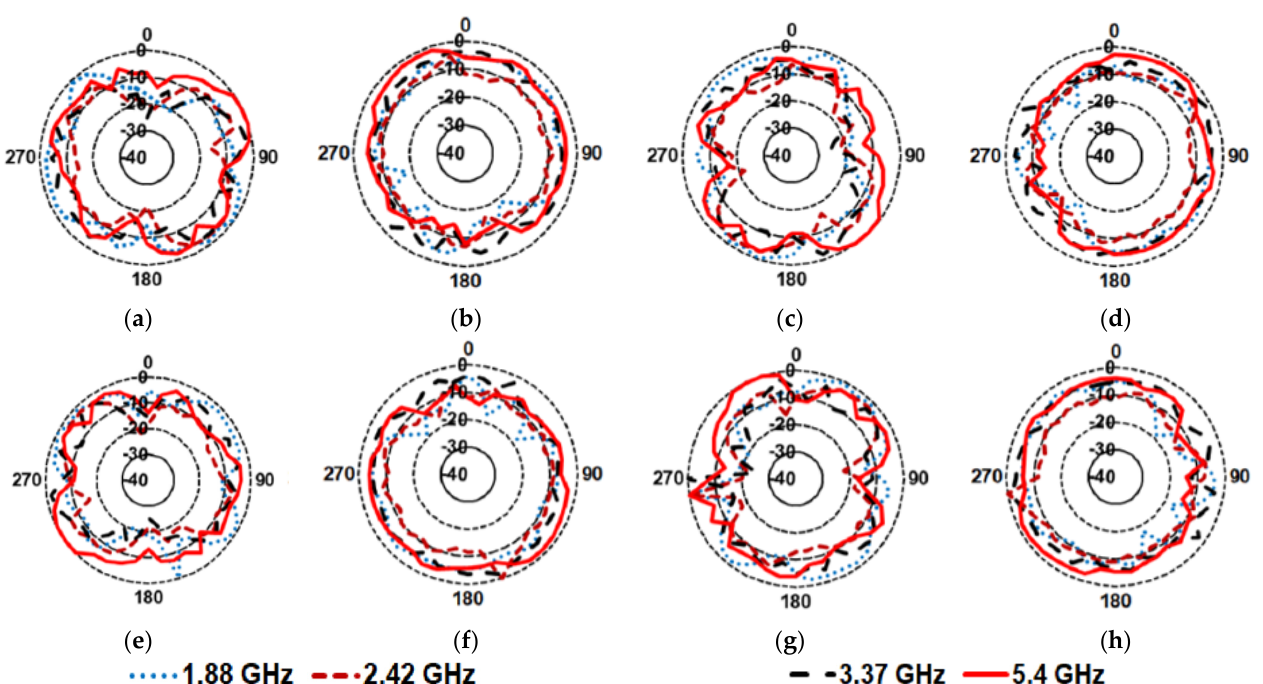
Figure 11. Measured radiation patterns of the DS MIMO antenna ( a ) antenna − 1, E − plane, ( b ) antenna − 1, H − plane, ( c ) antenna − 2, E − plane, ( d ) antenna − 2, H − plane, ( e ) antenna − 3, E − plane, ( f ) antenna − 3, H − plane, ( g ) antenna − 4, E − plane, ( h ) antenna − 4, H − plane.